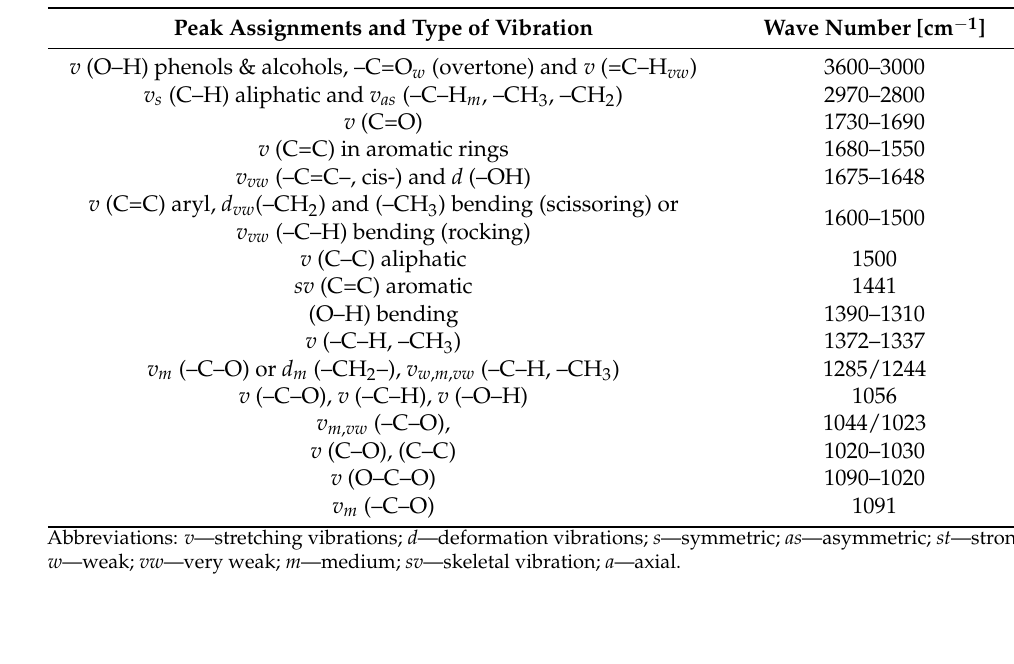
Table 2. Characteristic functional groups registered by FTIR analysis of freeze-dried extracts. Adapted from ref. [80].